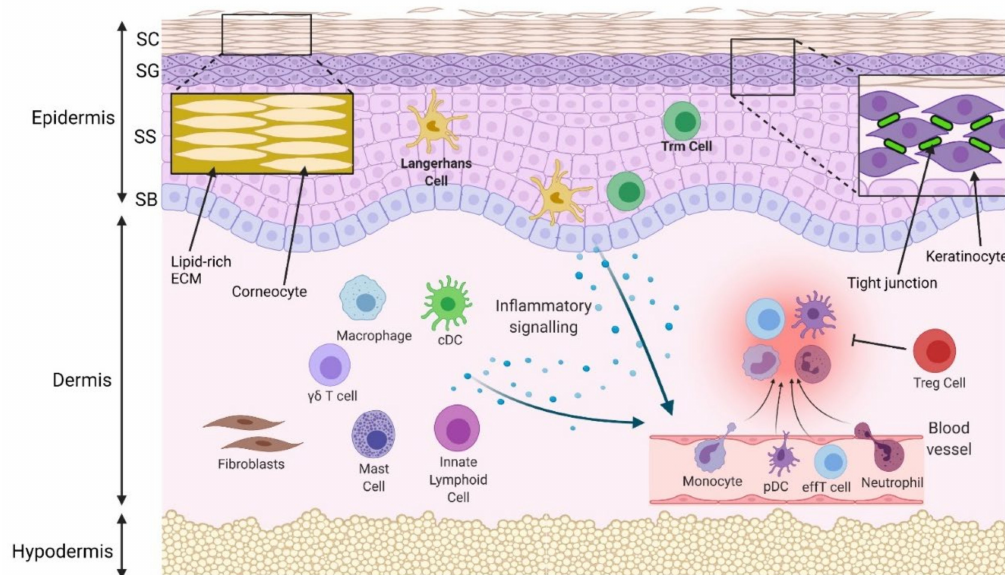
Figure 1. Physical and immune skin barrier in normal conditions. Densely packed corneocytes, surrounded by a lipidrich extracellular matrix (ECM) in the stratum corneum (SC), prevent passage of water and pathogens. Tight junctions between keratinocytes in the stratum granulosum (SG) prevent paracellular molecular passage. The stratum spinosum (SS) and stratum basale (SB) are deeper and are the initiation site of programmed keratinocyte proliferation and differentiation. Langerhans cells and some T resident memory (Trm) cells are located in the epidermis, while macrophages, conventional dendritic cells (cDCs), mast cells, innate lymphoid cells, γδ T cells and regulatory T cells (Tregs) are located in the uninflamed dermis. In response to pathogens, injury or allergens, these cells are activated. A number of different cytokines and chemokines may be released to compel the infiltration of inflammatory cells, such as neutrophils, monocytes, plasmacytoid dendritic cells (pDCs) and effector T cells (effT) from blood vessels. Collectively, they remove the invaded pathogens and clear cell debris. Regulatory cells resolve inflammation, and the skin barrier is